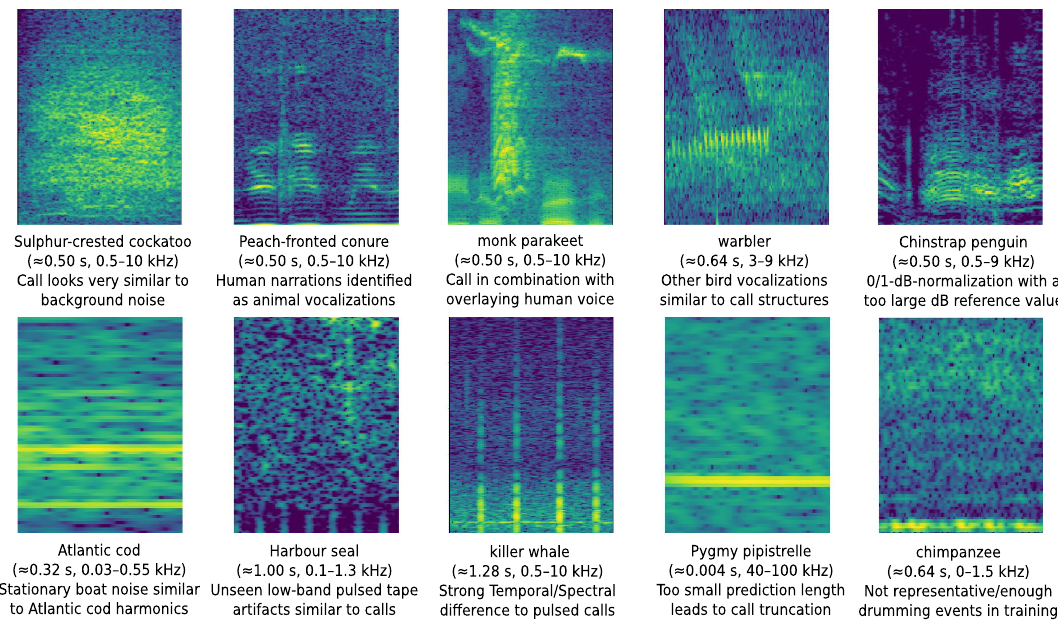
Figure 7. Spectrogram examples visualizing potential error sources leading to performance drops of ANIMAL- SPOT (created via Inkscape 39 , Version